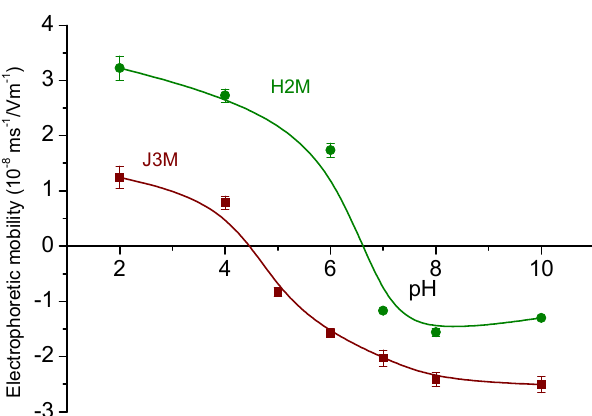
Figure 2. Electrophoretic mobility of the synthesized MNRs in 1 mM NaCl as a function of pH. Table 1. Electrophoretic mobility of bare MNRs, and of the same particles after being coated with polyelectrolytes as indicated. The mobility measured after contact with DOX in solution is also